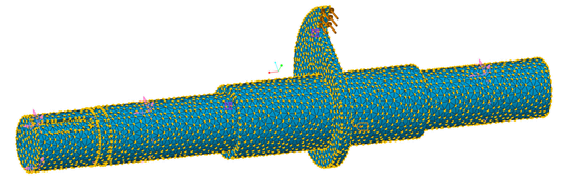
Figure 6 Network of finite elements on the shaft